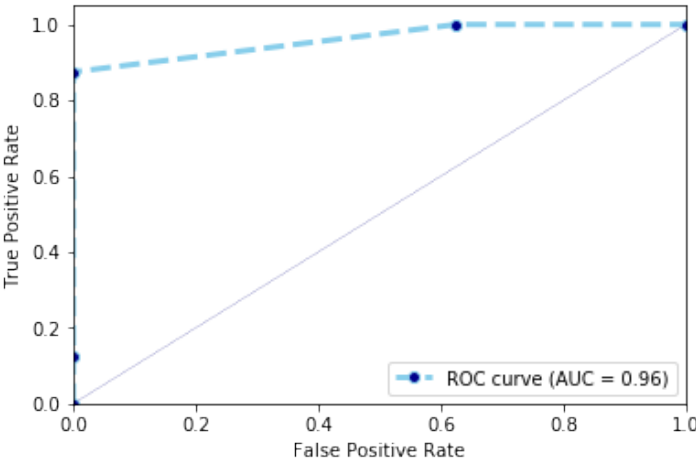
Figure 8. URFD dataset: ROC curve representing the cumulative rate between true positive rate and false positive